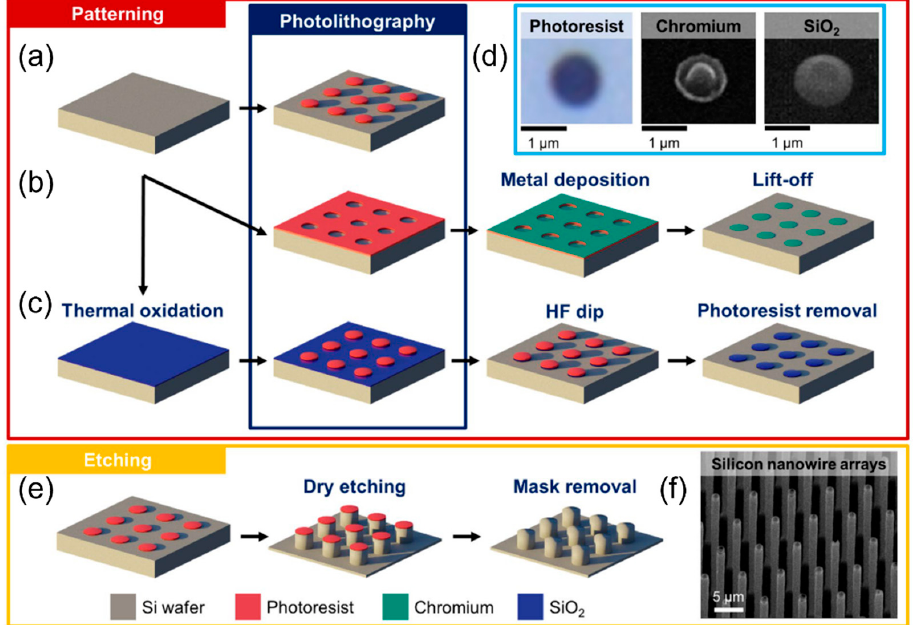
Figure 13. Different fabrication procedures of the vertical silicon (Si) nanowire array electrode using ( a ) photoresist, ( b ) chromium (Cr), and ( c ) silicon dioxide (SiO 2 ) as patterning masks along with photolithography and multiple processing techniques. ( d ) The circular patterns made by photoresist, Cr, and SiO 2 masks. ( e ) ICP/RIE process to etch silicon for the low-tortuous array structure. ( f ) SEM image of the vertical Si nanowire arrays. Reproduced with permission from ref. [181]. Copyright 2021, Springer Nature.